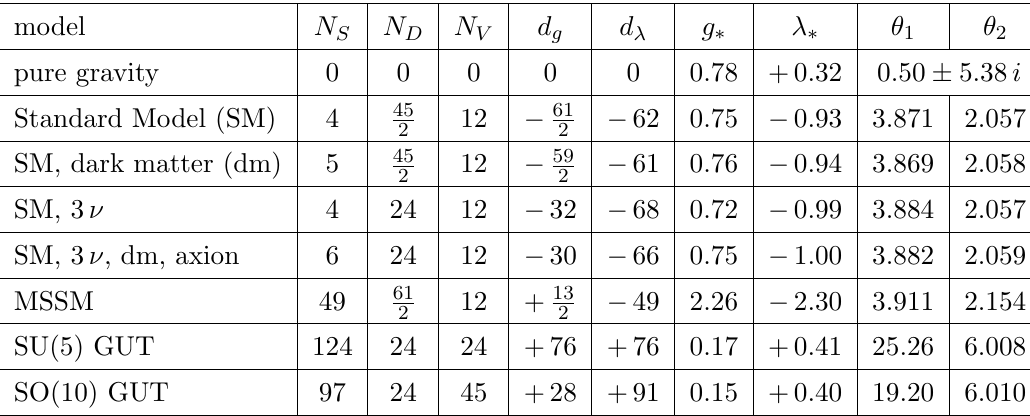
Table 3 . Fixed point structure arising from the (cid:12)eld content of commonly studied matter models. All models apart from the minimally supersymmetric standard model (MSSM) and the grand uni(cid:12)ed theories (GUT), sit in the lower-left quadrant of (cid:12)gure 4. All matter con(cid:12)gurations possess a single ultraviolet attractive NGFP with real critical